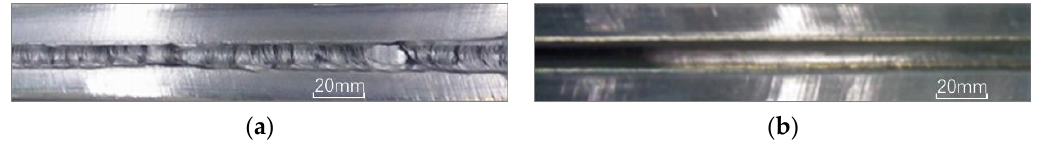
Figure 12. Weld formation for two welding positions: ( a ) climbing welding; and ( b ) flat welding.